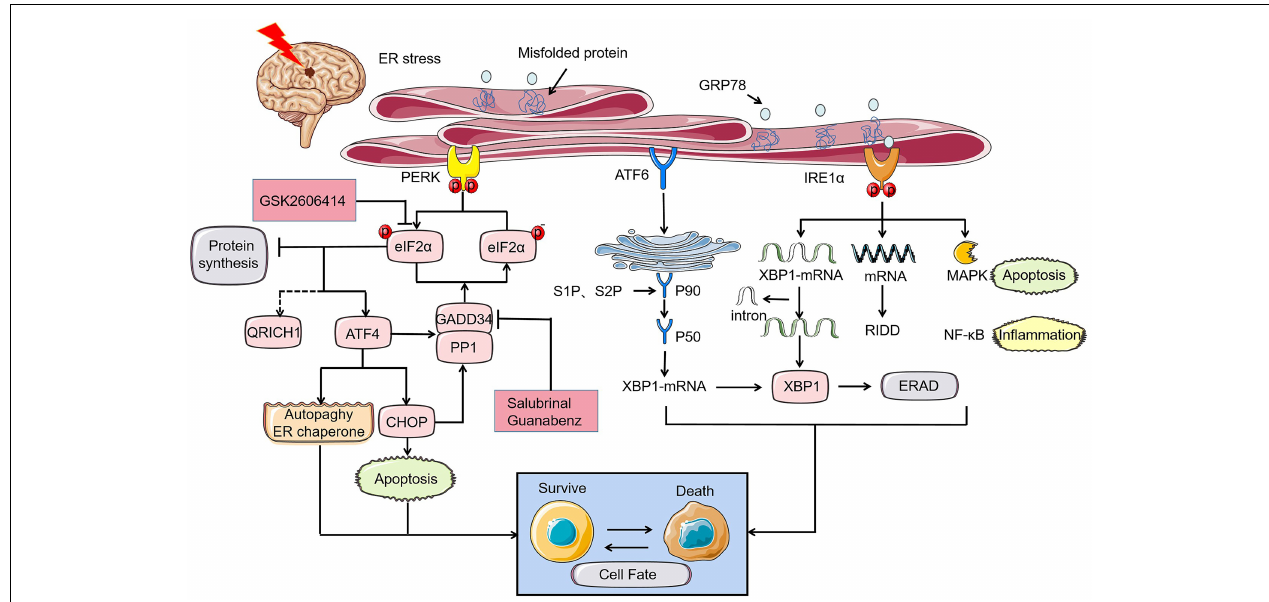
FIGURE 1 | UPR of ER stress in cerebral ischemia determines cell fate through PERK, IRE1, and ATF6 pathways. Under the ischemic state, PERK-eIF2 α -ATF4-CHOP axis controls cell fate by apoptosis where p- eyIF2 α play a key role in inhibiting protein synthesis and its role will be reversed by PERK inhibitor GSK2606414. GADD34, which is simultaneously regulated by ATF4 and CHOP promotes promoting the dephosphorylation of eIF2 α under prolonged ER stress. Similarly, the role of GADD34 can disappear with the intervention of salubrinal and guanabenz. The rescue of cell fate by ATF4 is mainly achieved by inhibiting autophagy and controlling the ER chaperones. The different expression of XBP1 induced by ATF6 and IRE1 α can also bring disparate endings to the cell. MAPK apoptosis pathway and NF- κ B inflammation related to IRE1 α can directly determine cell